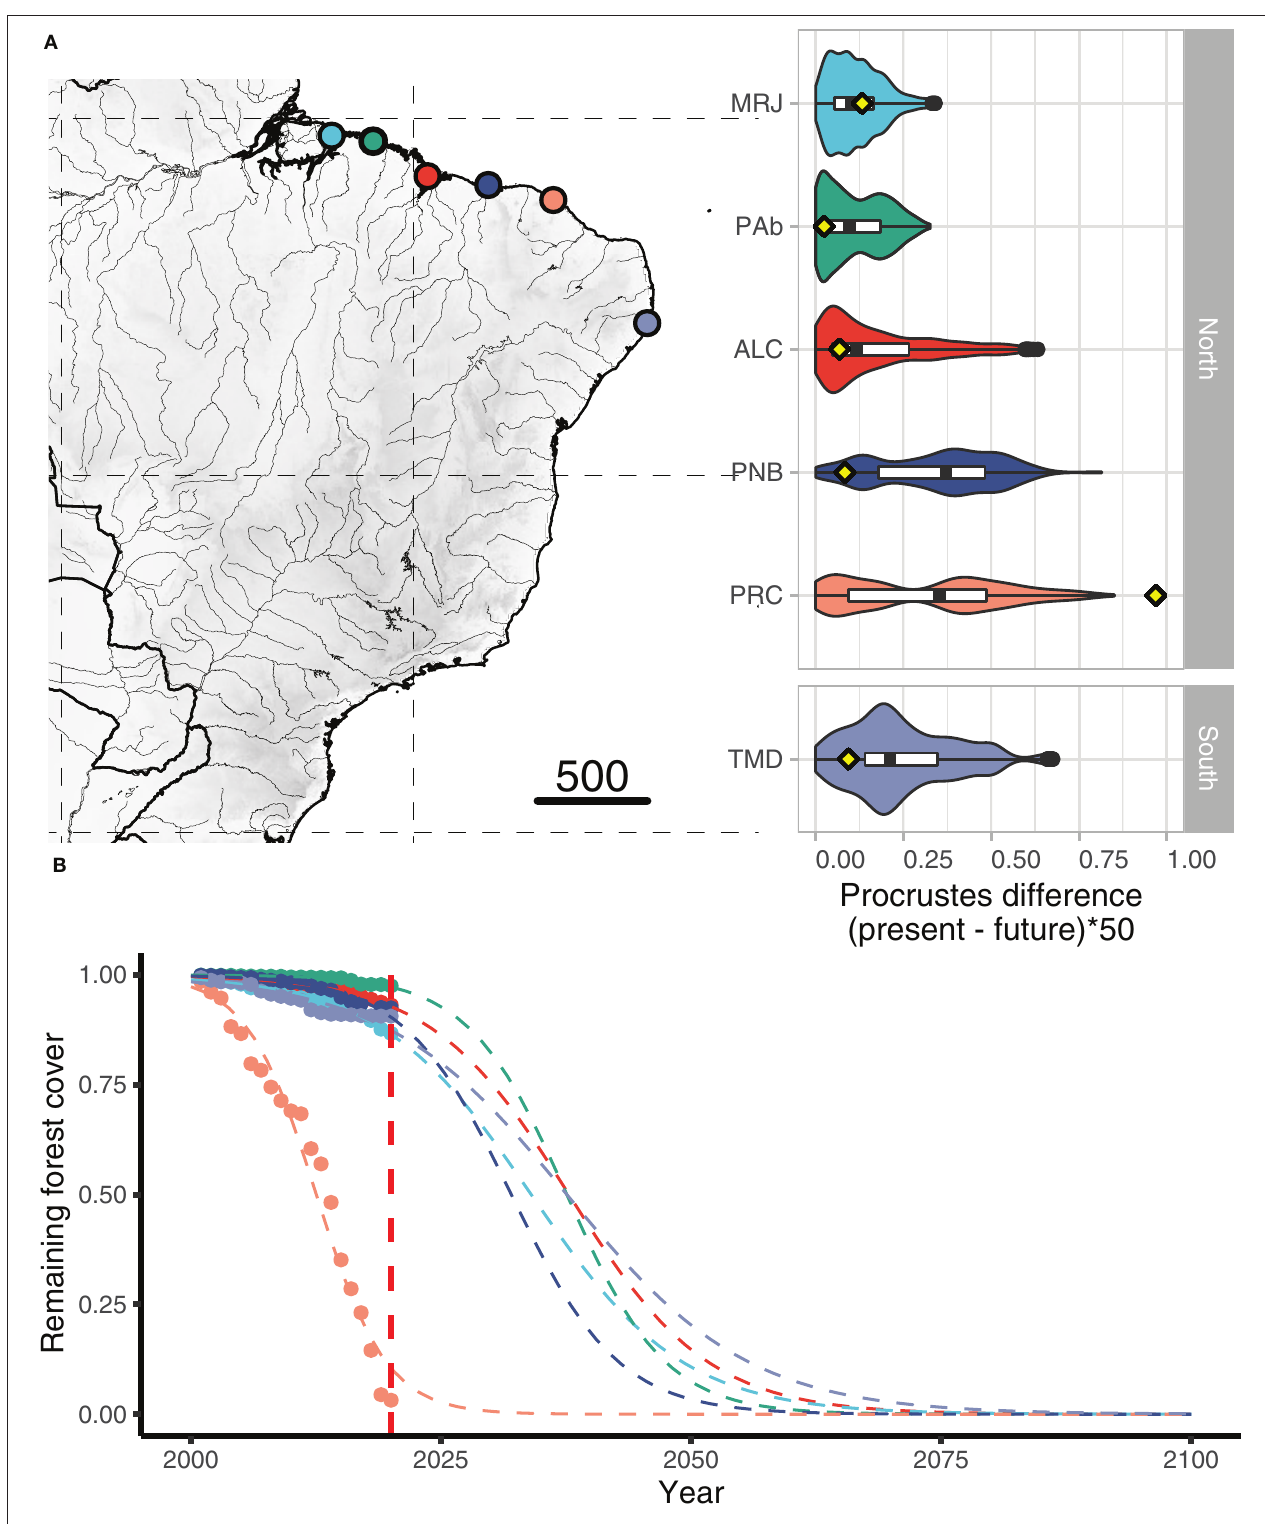
FIGURE 3 | (A) Procrustes differences between the present and future frequencies of the outlier and reference (i.e., neutral) loci for populations of Avicennia germinans obtained with gradient forest and RDA/PCAdapt; the yellow dots represent the proportion of forest cover lost by 2020. (B) Yearly deforestation rates (2000–2020) for each A. germinans region included in our